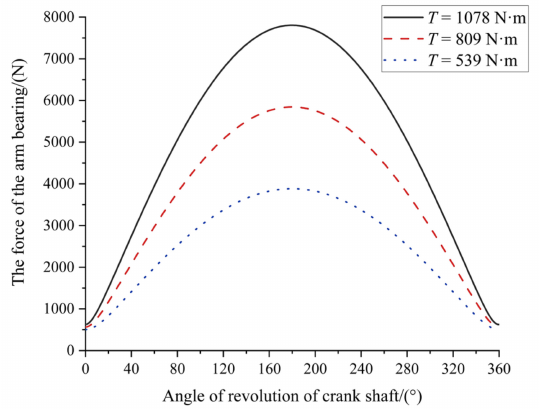
Figure 6. Force curve of the needle roller bearing.